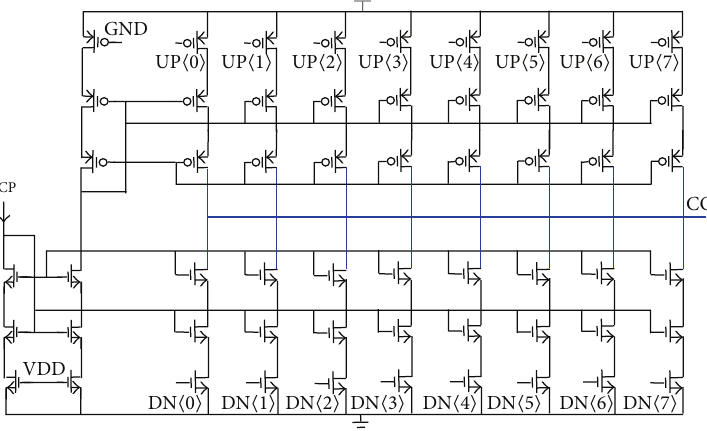
Figure 8: Multiphase charge pump schematic.